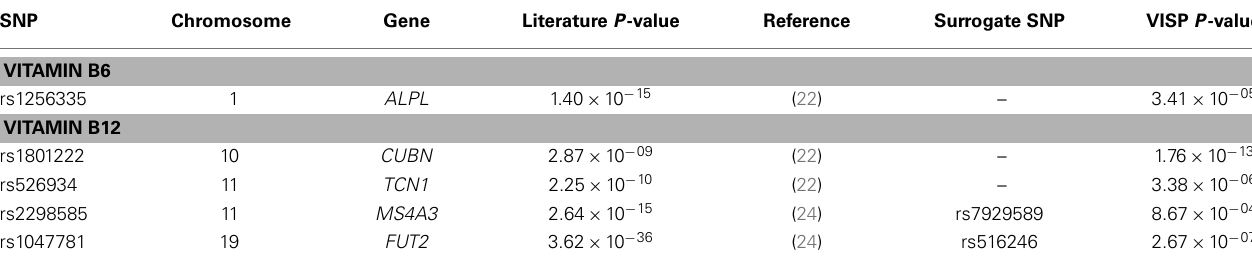
Table 3 | Significant associations of 16 previously reported associations ofVitamin B 6 ,Vitamin B 12 , and